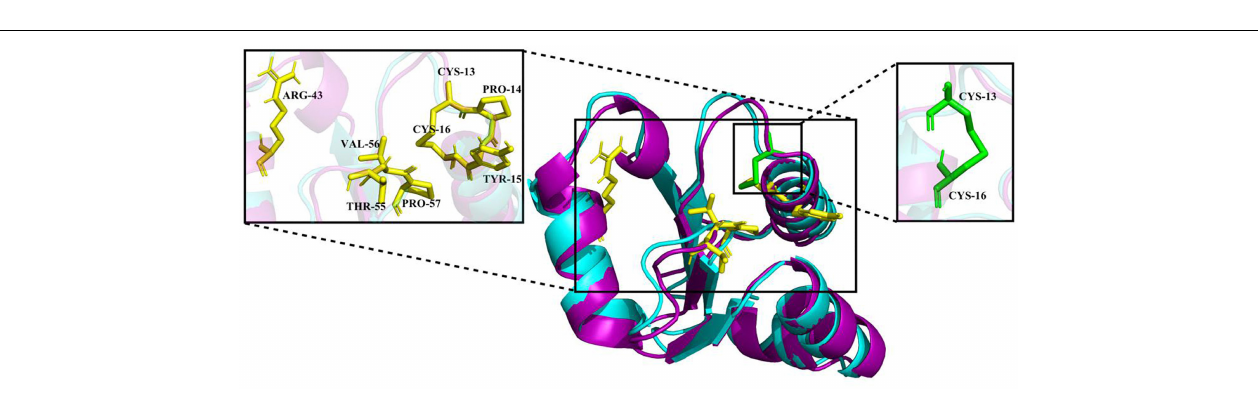
FIGURE 2 | A 3D structure model of Ps-Grx (purple) superimposed on EcGrx3 (cyan, PDB ID: 1FOV). The GSH binding motifs and active sites are indicated as stick models colored in yellow and green, respectively.